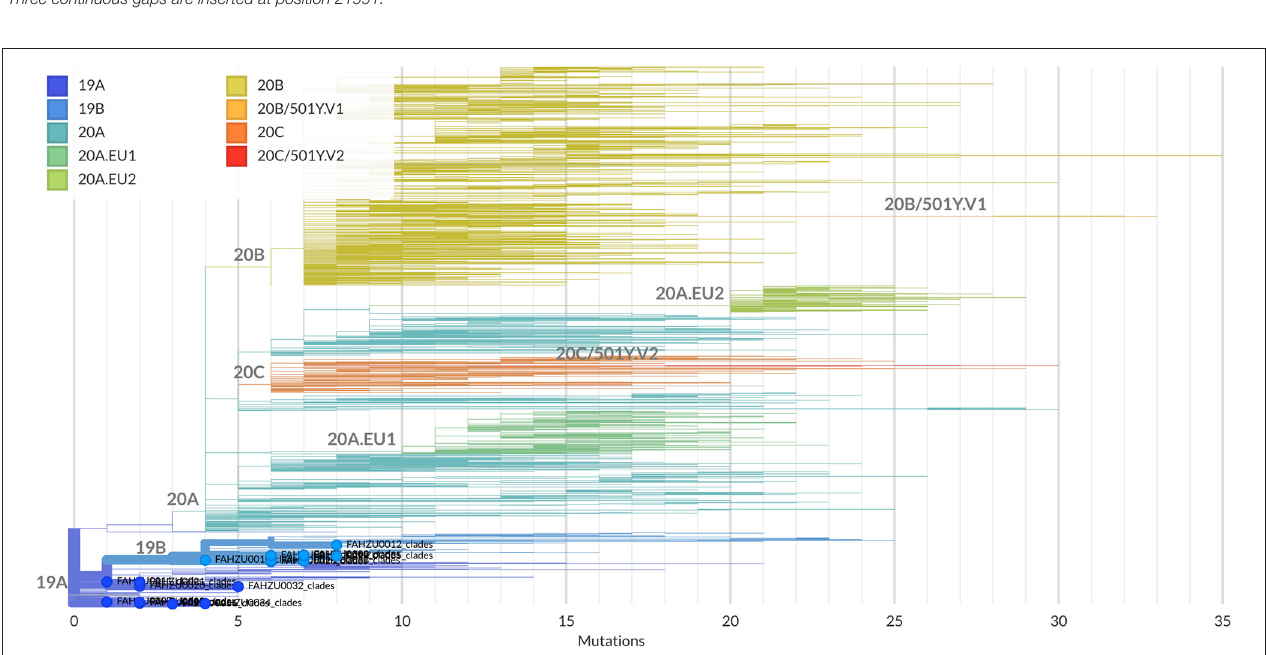
FIGURE 1 | Clade assignment of the 19 Henan sequences analyzed by the Nextclade. Currently, five major clades are defined: 19A and 19B emerged in Wuhan and have dominated the early outbreak; 20A emerged from 19A out of dominated the European outbreak in March and has since spread globally; 20B and 20C are large genetically distinct subclades 20A. The 19 Henan sequences are highlighted and marked with solid circles at the end of their